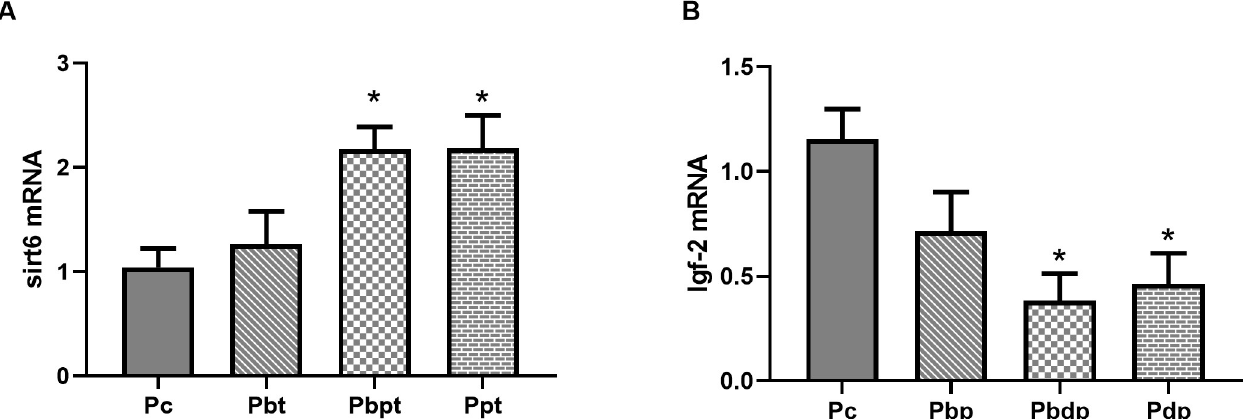
Fig 4. Comparison of cardiac gene expression among the pup groups. (A) cardiac Sirt6 expression in adult male pup groups. (B) cardiac IGF-2 expression in adult male pup groups. Abbreviations: P c group (n = 5), pups of sedentary mothers; P bp group (n = 6), pups of mothers who exercise only before pregnancy; P bdp group (n = 4), pups of mothers who exercise prior to and during pregnancy; P dp group (n = 6), pups of mothers who exercise only during pregnancy. Data presented as means ± S.E.M. � p < 0.05 vs. Pup Control group. One-way ANOVA followed by Dunnett’s multiple comparisons